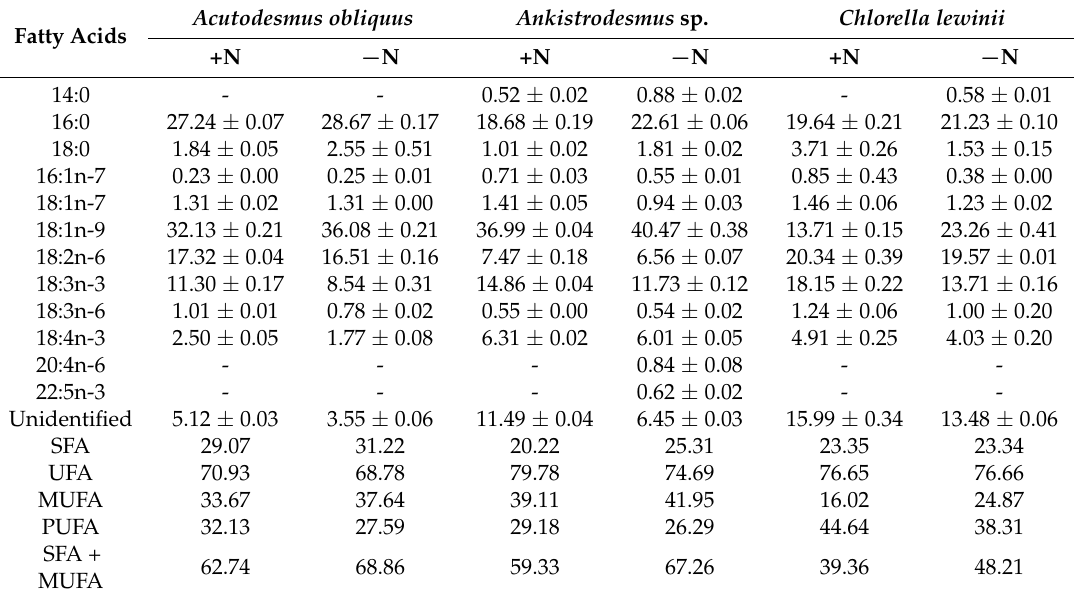
Table 2. Effect of nitrogen deficiency on fatty acid profiling in three native microalgal species from the Peruvian Amazon. Acutodesmus obliquus Ankistrodesmus sp. Chlorella